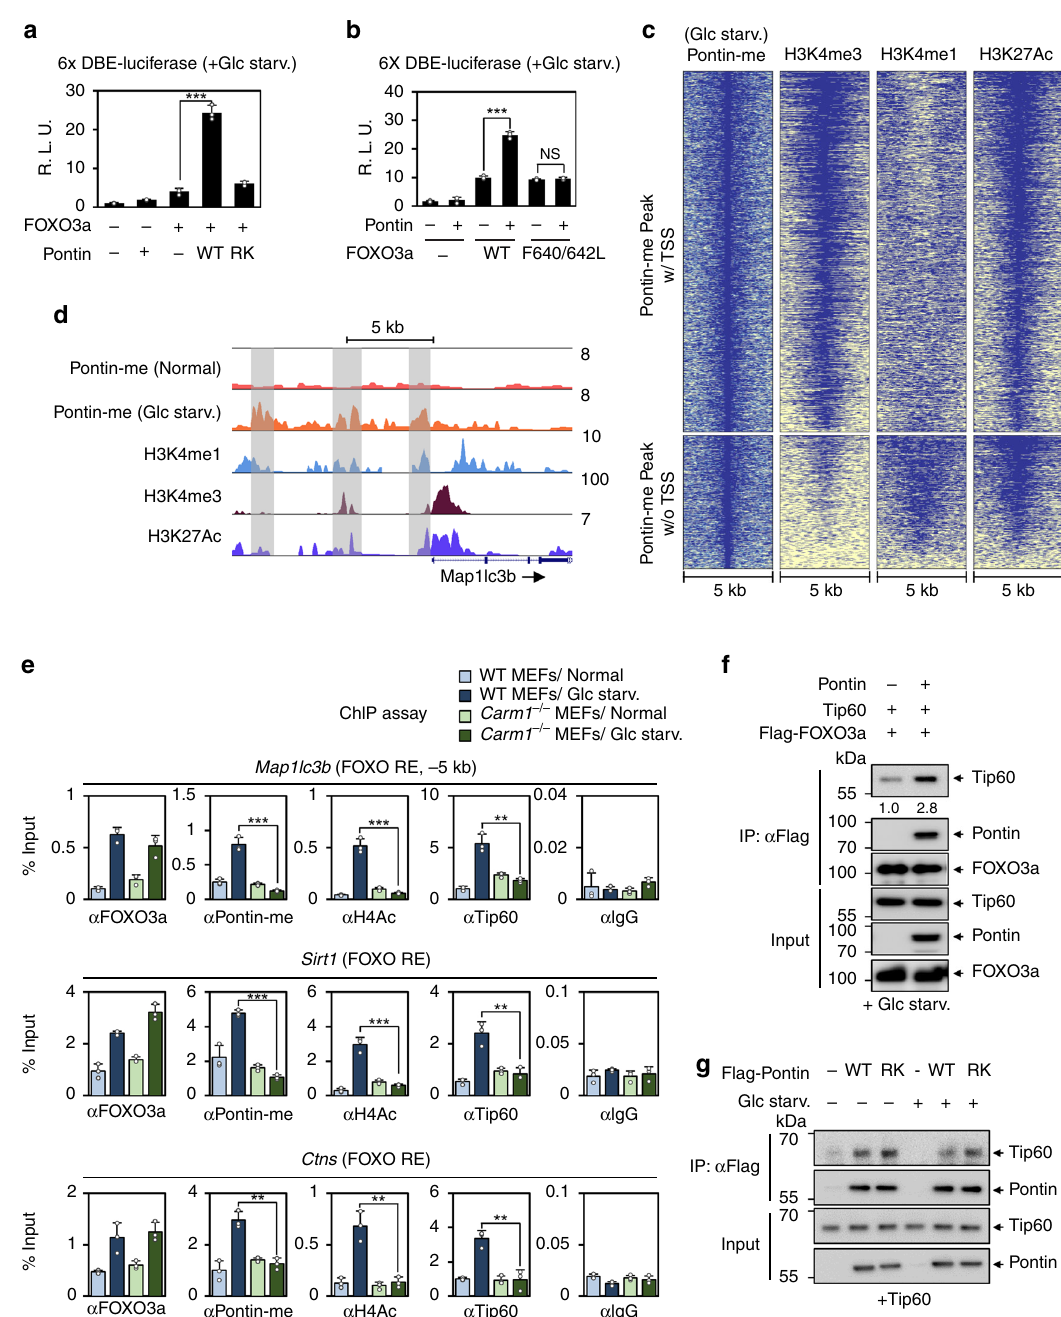
Fig. 6 Methylated Pontin and Tip60 activate FOXO3a target genes with histone H4 acetylation. a Effect of Pontin WT or RK on 6x DBE (FOXO RE)- luciferase reporter. Bars, mean ± s.e.m; n = 3; *** p < 0.001. Statistics by two-tailed t -test. b Effect of FOXO3a WT, or F640L/F642L mutant on 6× DBE- luciferase reporter. Bars, mean ± s.e.m; n = 3; *** p < 0.001, NS non-signi fi cant. Statistics by one-way ANOVA with post hoc Tukey ’ s test. c Heatmap showing methylated Pontin near the TSS (above) or distally located to TSS (below). The data on H3K4me1, H3K4me3, and H3K27ac were obtained from MEFs under normal conditions. d Pro fi les of methylated Pontin (Normal), methylated Pontin (Glc starv.), H3K4me1, H3K4me3, and H3K27Ac ChIP-seq occupancy in the locus of the Map1lc3b gene. Gray boxes indicate possible Pontin binding sites. e ChIP assays were performed using anti-FOXO3a, anti- Pontin-me, anti-H4ac, anti-Tip60, and anti-IgG antibodies on FOXO REs in WT or Carm1 − / − MEFs in the absence or presence of glucose starvation. Bars, mean ± s.e.m.; n = 3; ** p < 0.01, *** p < 0.001. Statistics by two-tailed t -test. f Co-immunoprecipitation assay between FOXO3a and Tip60 in the absence or presence of Pontin. g Co-immunoprecipitation assay between Tip60 and Pontin WT or RK mutants in the absence or presence of glucose starvation. Source data are provided as a Source Data fi